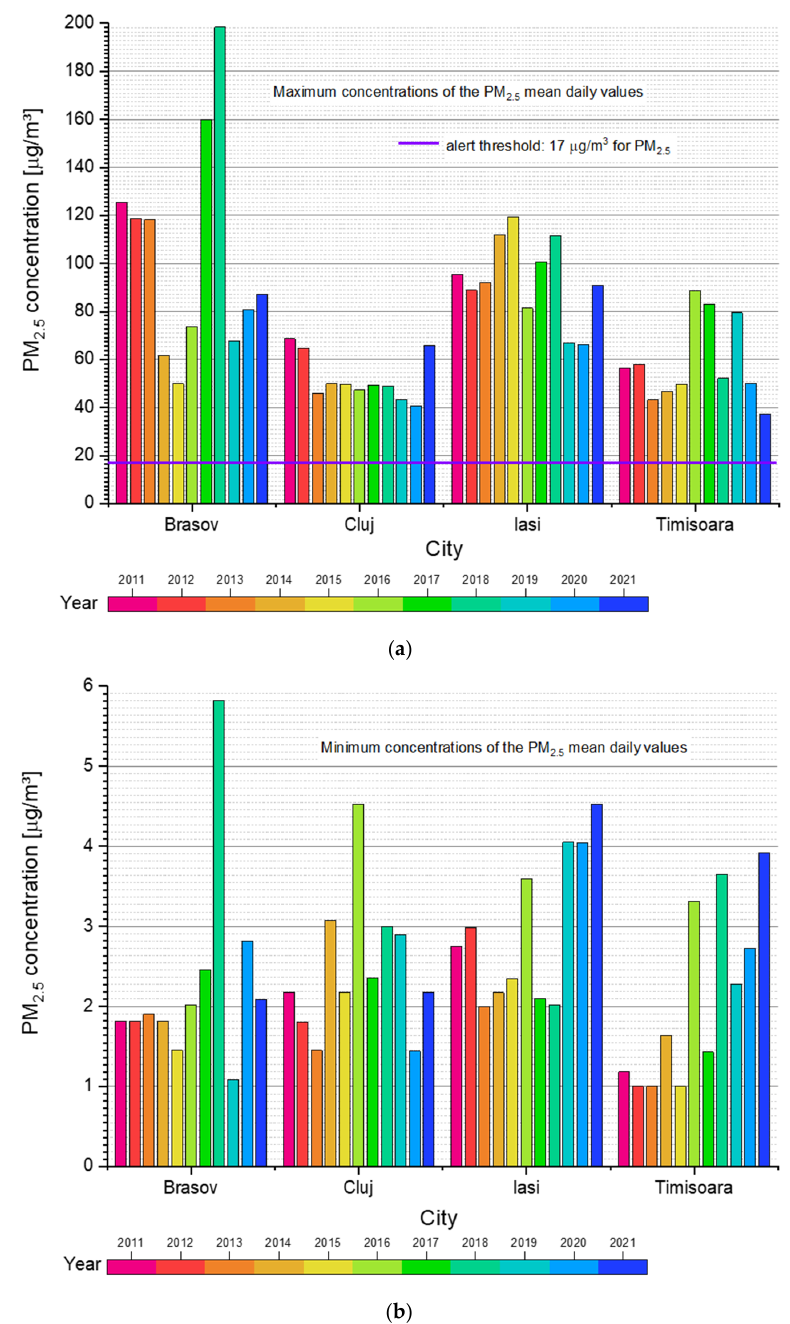
Figure 5. ( a ) Maximum concentrations of PM 2.5 mean daily values depending on the alert threshold; ( b ) minimum concentrations of PM 2.5 mean daily values depending on the alert threshold.